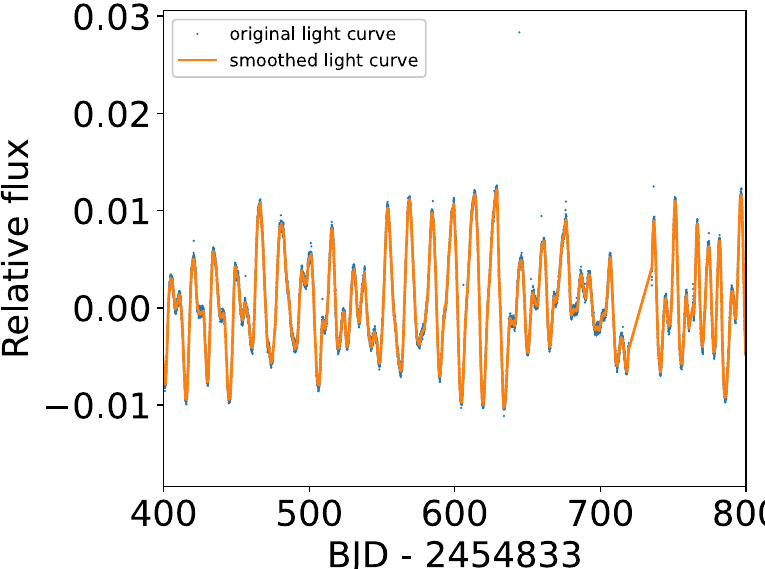
Figure 2. Kepler light curve for the star KIC 9017220. The full light curve and the full smoothed light curve are shown in Figure